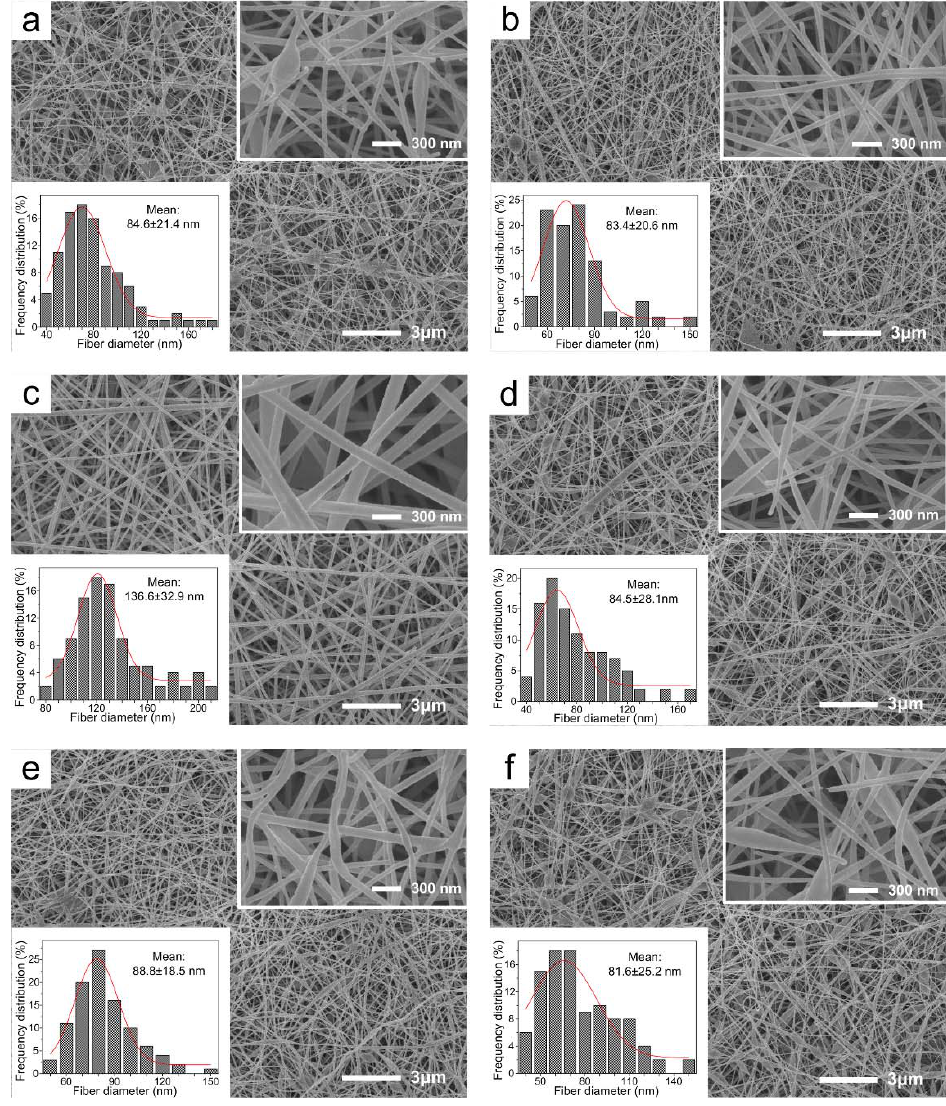
Figure 1. SEM images of drug-loaded nanofibrous membranes: ( a ) chitosan (CS) / poly (vinyl alcohol) (PVA) nanofibrous membrane, ( b ) CS / PVA / graphene oxide (GO) nanofibrous membrane, ( c ) CS / PVA / Ciprofloxacin hydrochloride (CipHcl) nanofibrous membrane, ( d ) CS / PVA / GO / CipHcl nanofibrous membrane, ( e ) CS / PVA / Ciprofloxacin (Cip) nanofibrous membrane, ( f ) CS / PVA / GO / Cip nanofibrous membrane.